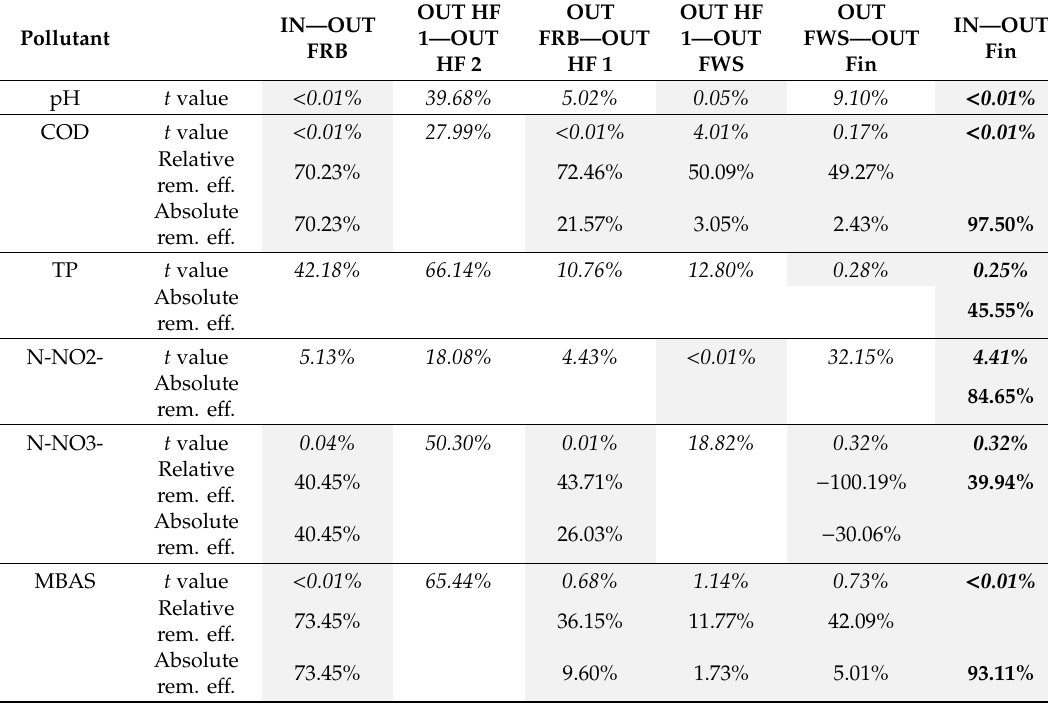
Table 3. Results of t -test (expressed in percentage and italics) and removal e ffi ciencies (absolute in comparison to influent wastewater and relative among the stages) of the CW of Cecchi winery: influent (IN); e ffl uent from the 1st stage FRB beds (OUT FRB); e ffl uent from the 2nd stage refurbished HF